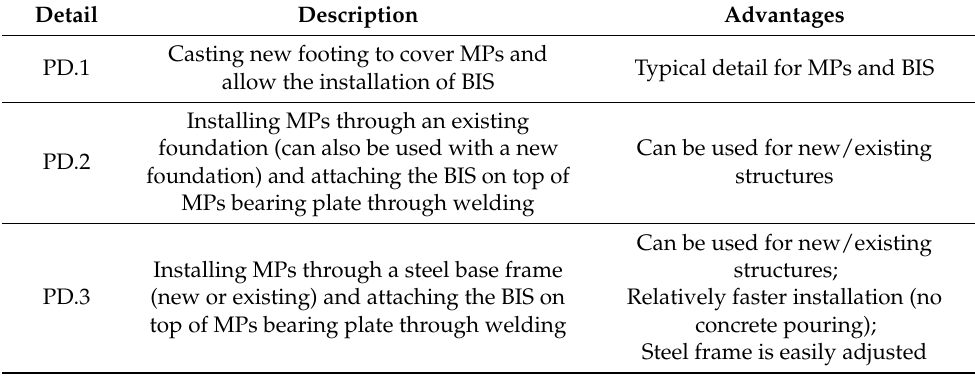
Table 3. Comparison between the proposed details for combining MPs with BIS [1,20,32,33].